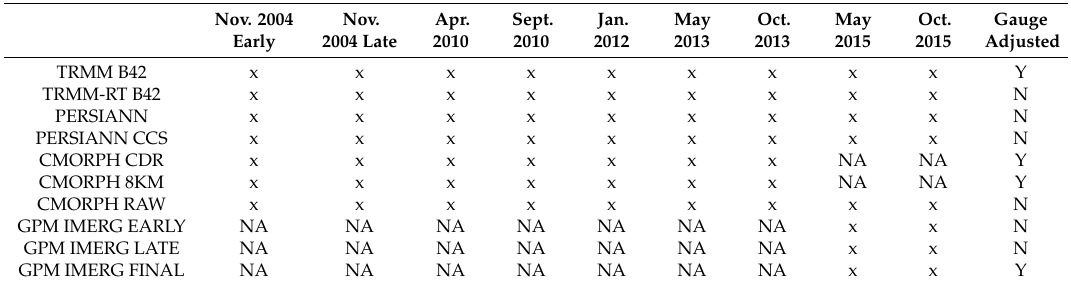
Table 1. Description of satellite precipitation dataset